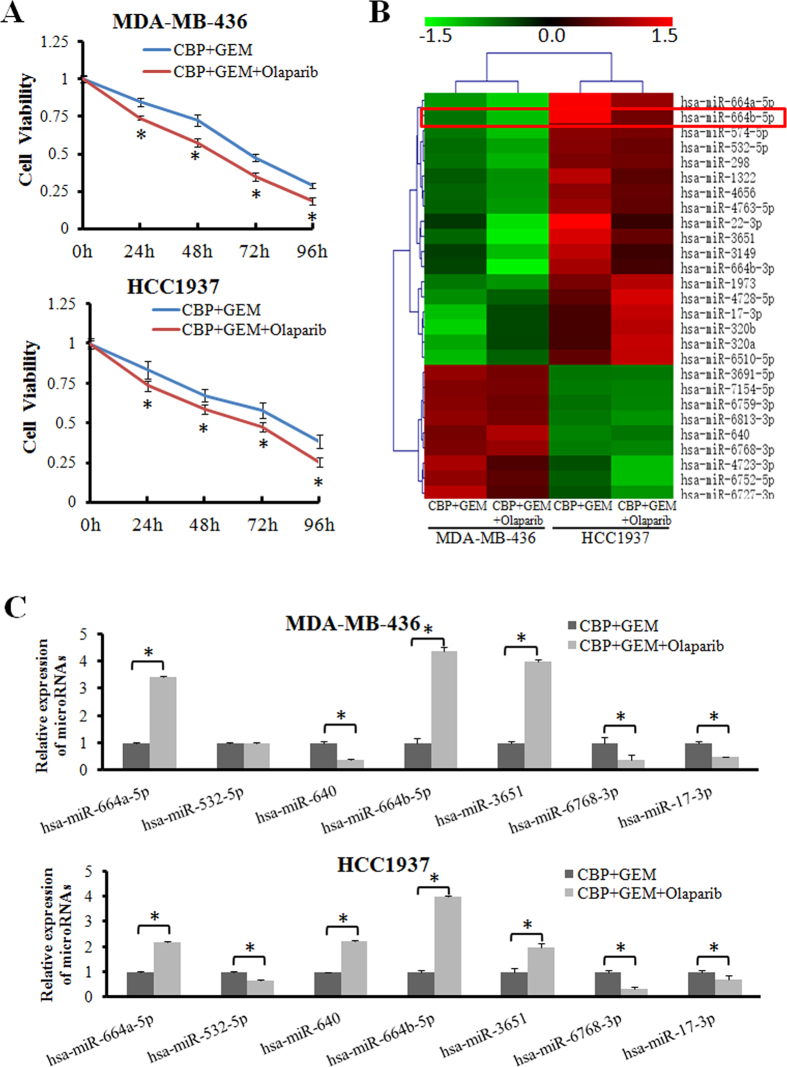
Adding PARP inhibitor to CBP plus GEM upregulates miR-664b-5p expression.(A) The BRCA1-mutated TNBC cell lines MDA-MB-436 and HCC1937 were treated with CBP (10 μM) plus GEM (100 nM) combined with or without olaparib (10 μM) for the indicated times, and then, the cell viability was determined with an MTT assay. The results show data from six independent experiments expressed as the mean ± SD. p < 0.05. (B) A miRNA microarray was performed to detect differentially expressed miRNAs of MDA-MB-436 and HCC1937 cells treated with CBP plus GEM combined with or without olaparib for 72 h. The green in the legend represents down-regulation, and the red represents upregulation (>1.5-fold change in expression, p < 0.05). (C) Validation by qRT–PCR of candidate miRNAs that showed significant differential expression in the miRNA microarray. The error bars represent the mean of three separate determinations ± the standard deviation (SD). *p < 0.05.